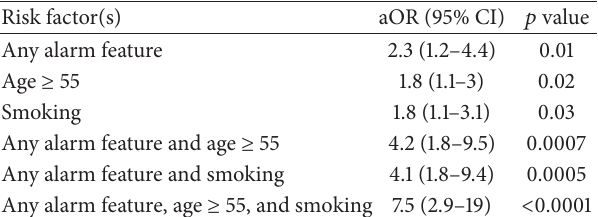
Table 4: Multivariate analysis of association of risk factors with significant endoscopic findings; Grady Memorial Hospital, Atlanta, Georgia, June 1, 2011–July 1,